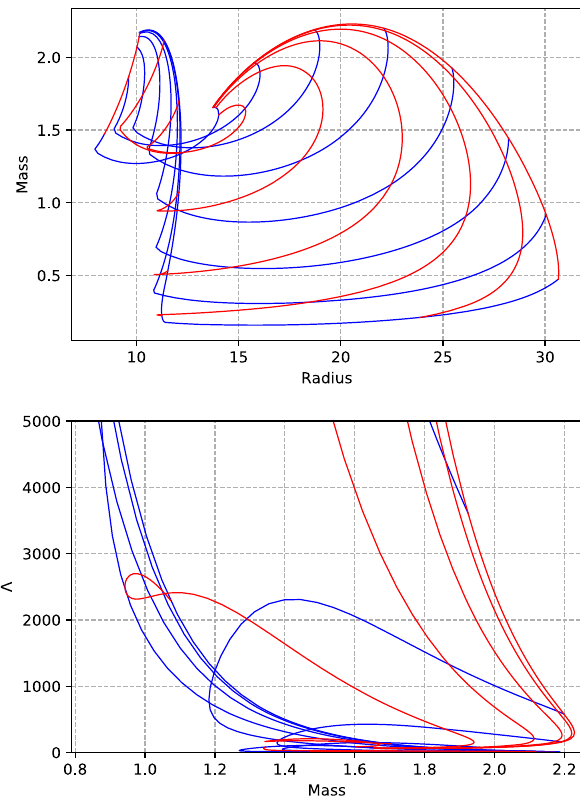
Fig. 10 Mass–radius (up) and TLN–mass (down) relations of the hybrid stars of type (IIIa) and (IIIb) in Fig. 1 for APR4 EoS and for dark matter EoS with B = 0 . 055. The colouring means the same as that in Fig. 9